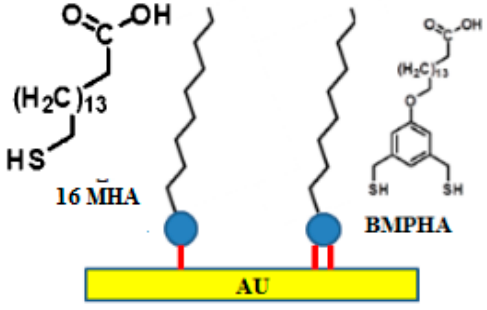
Figure 2. Structures of two carboxylic acid terminated alkanethiols.